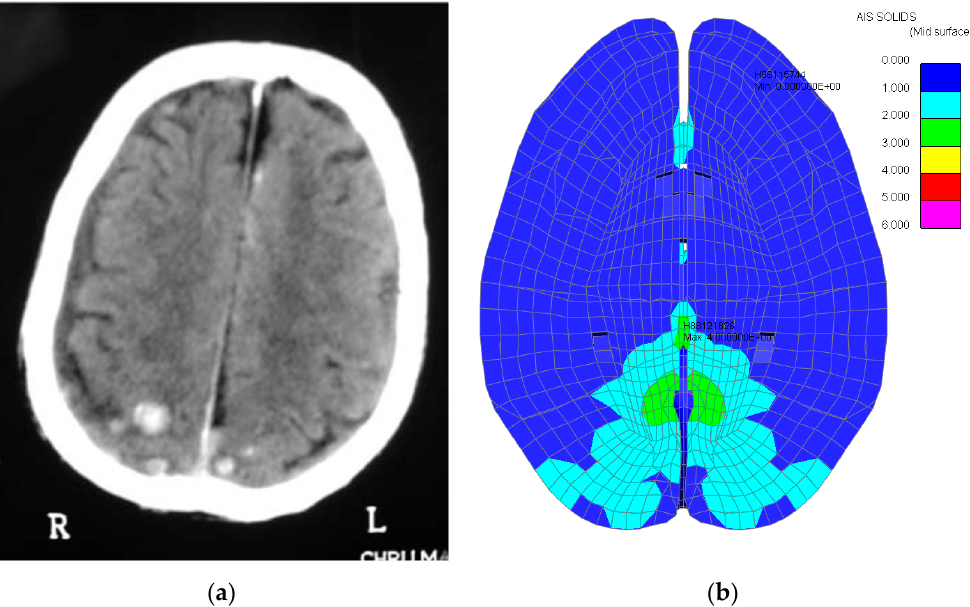
Figure 14. First Accident. Brain trauma (coup). Comparison between CT scan [16] ( a ) CT Scan (coup) and computer predictions ( b ) Computer Simulation (coup).